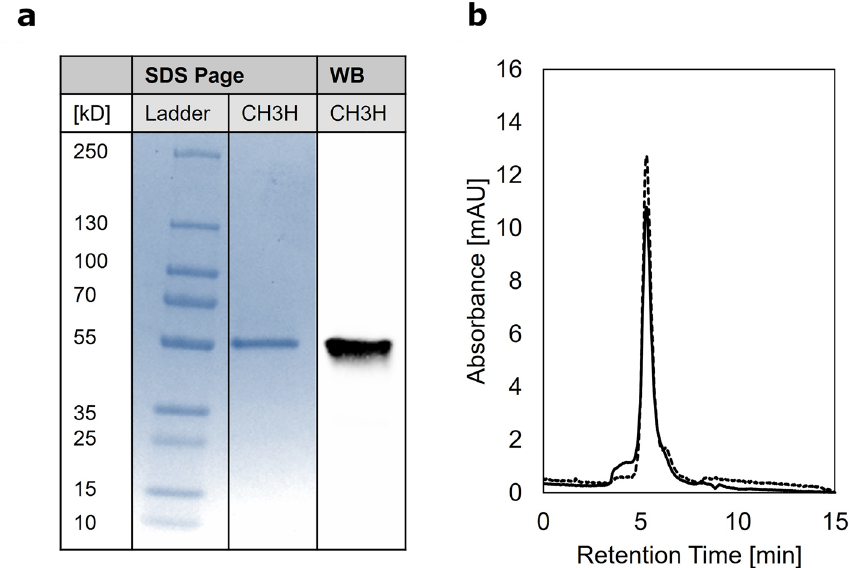
Figure 5. ( a ) SDS-PAGE and western blot and ( b ) SEC-chromatogram of the purified recombinant Dv CH3H. Solid line indicates absorbance at 280 nm and the dashed line the absorbance at 425 nm, where the heme of the